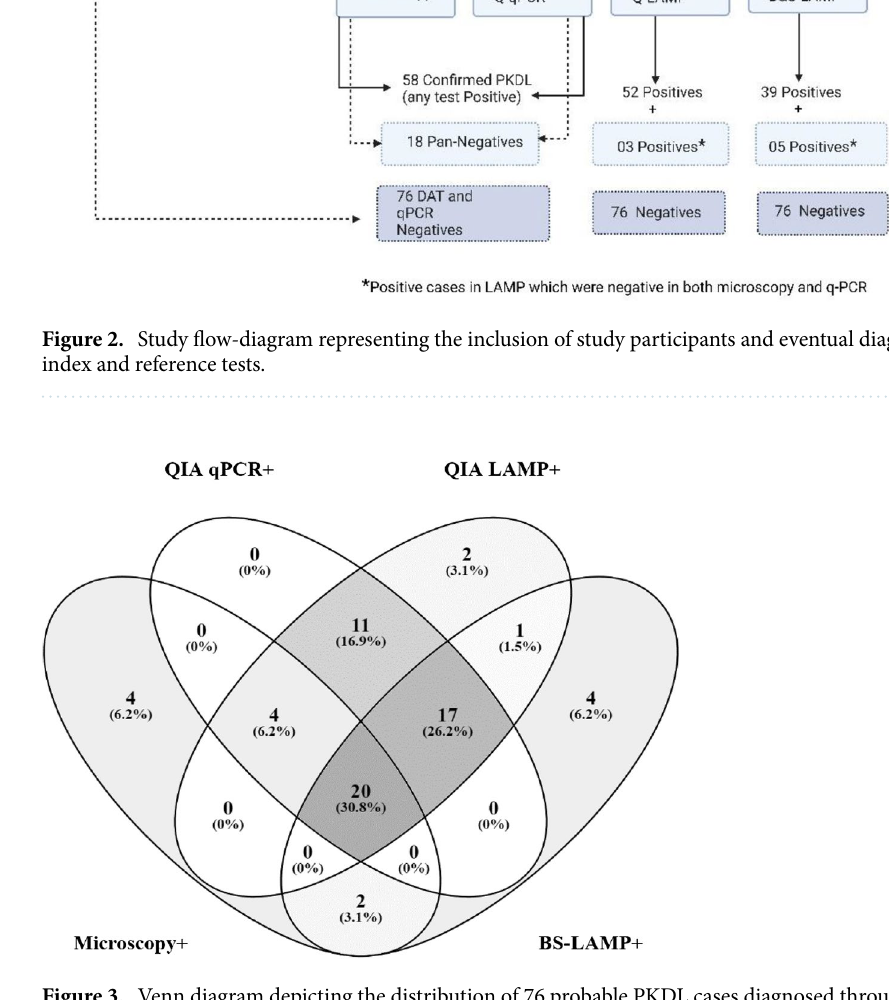
Figure 3. Venn diagram depicting the distribution of 76 probable PKDL cases diagnosed through four different methods. Among 76 probable patients, 20 (30.8%) cases were positive by all of the diagnostic methods where 65 cases were positive by at least one method. Microscopy detected 30 cases as positive where 4 cases were solely detected through Microscopy. Q-qPCR was positive in 52 (68.42%) cases and that 52 cases were positive by